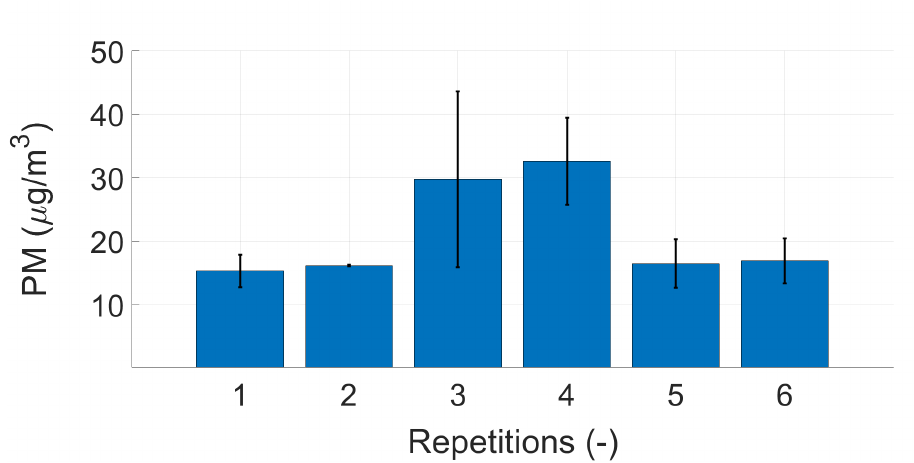
Figure A4. The mean values of PM measurements of gasoline.